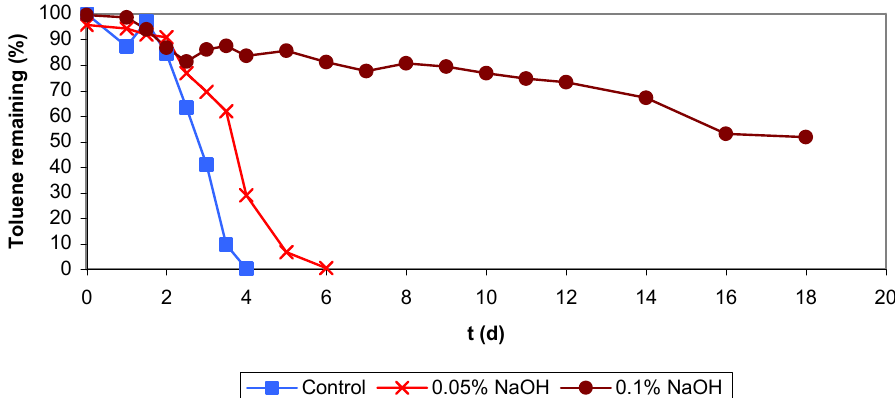
Figure 5. Batch assays with NaOH and toluene (11 µL volume